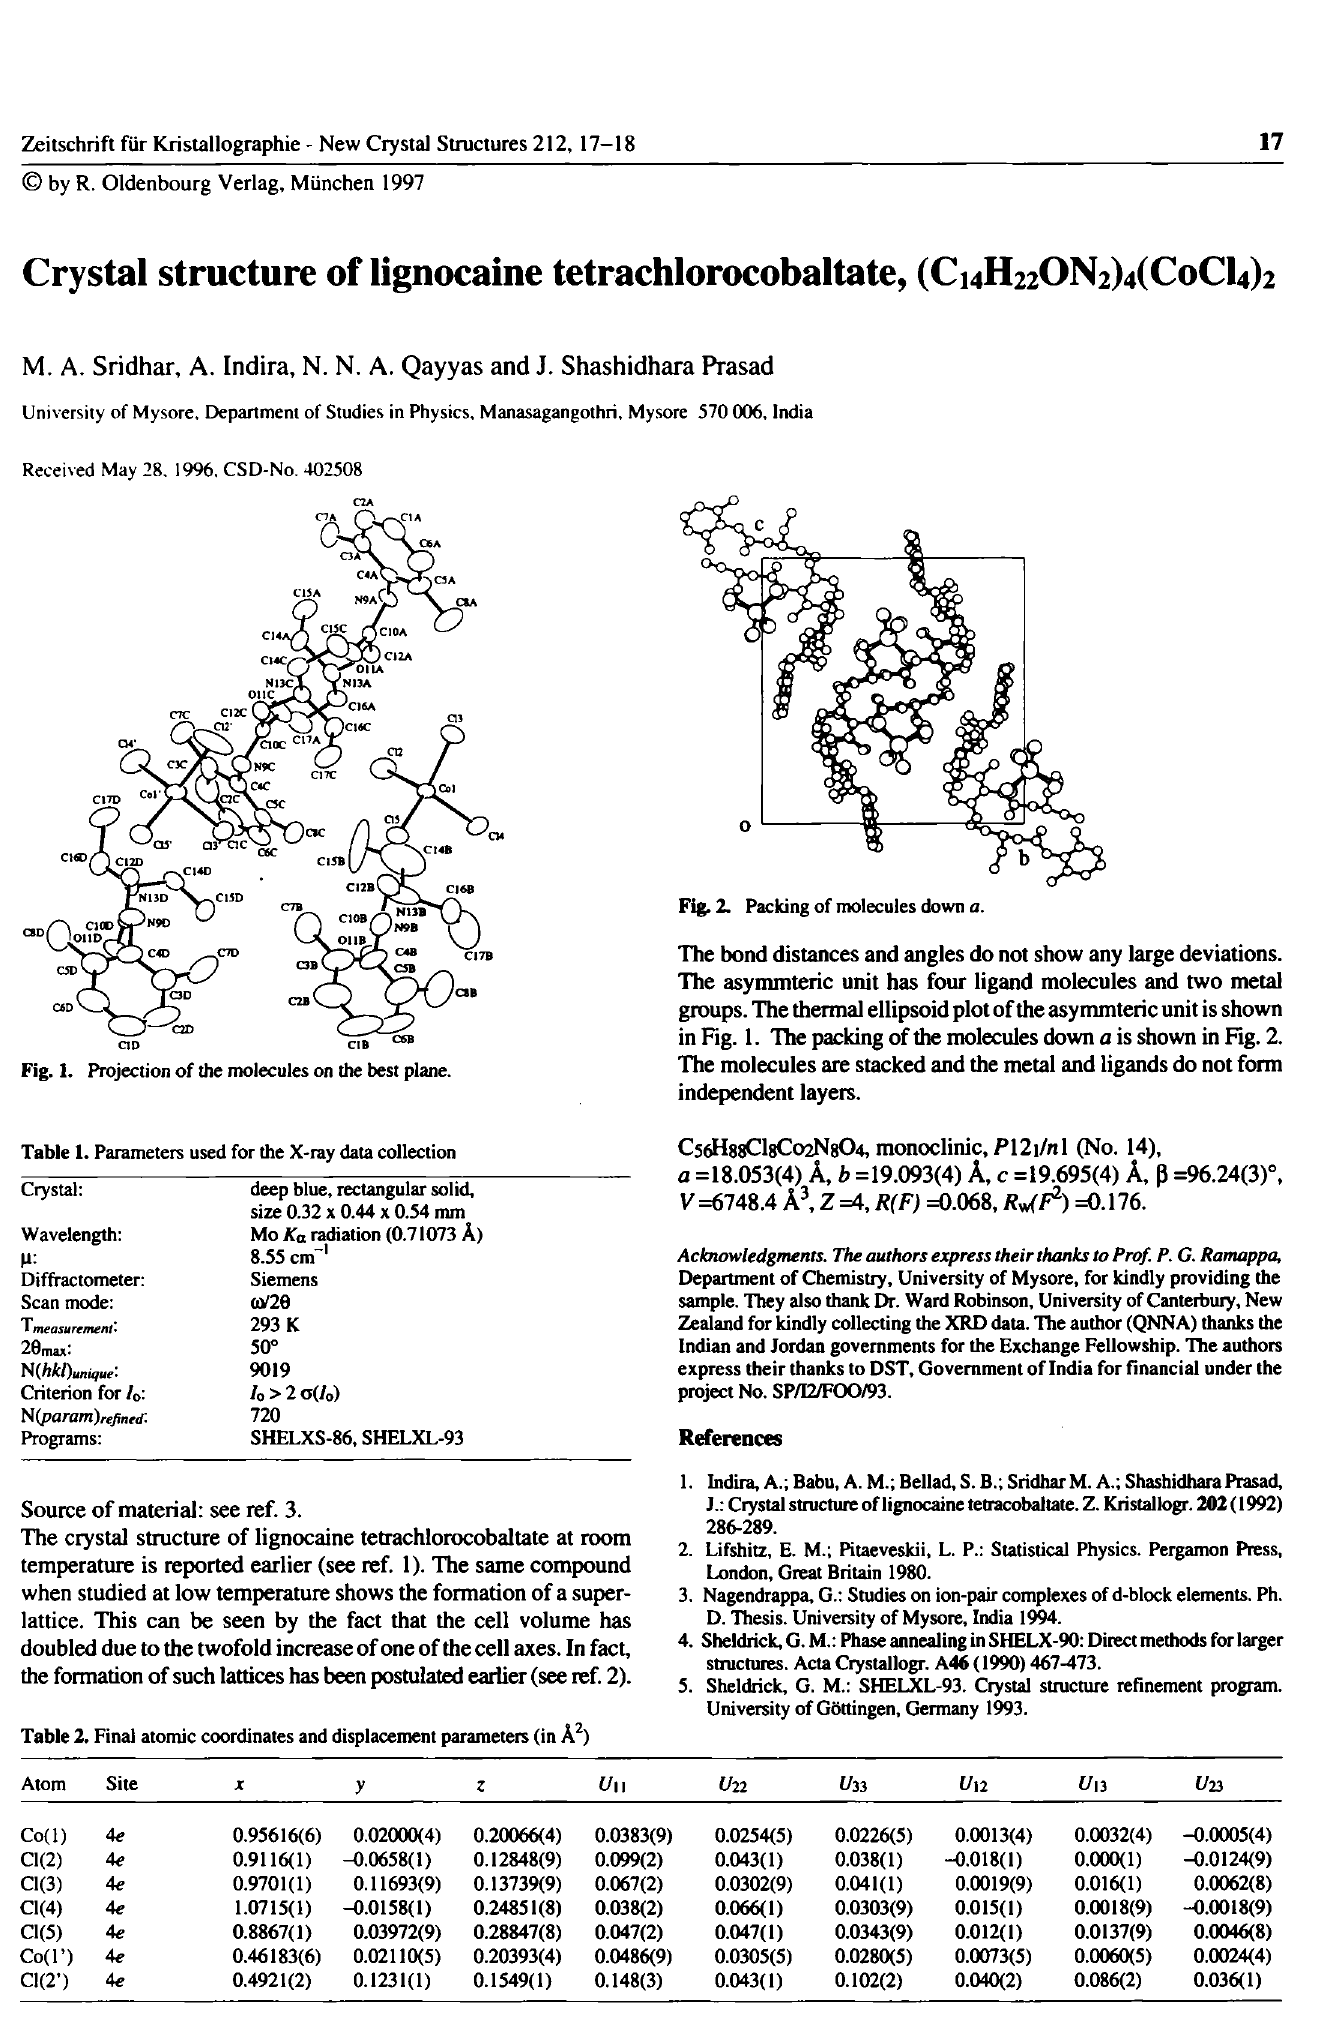
Table 2. Final atomic coordinates and displacement parameters (in Â 2 ) Atom Site